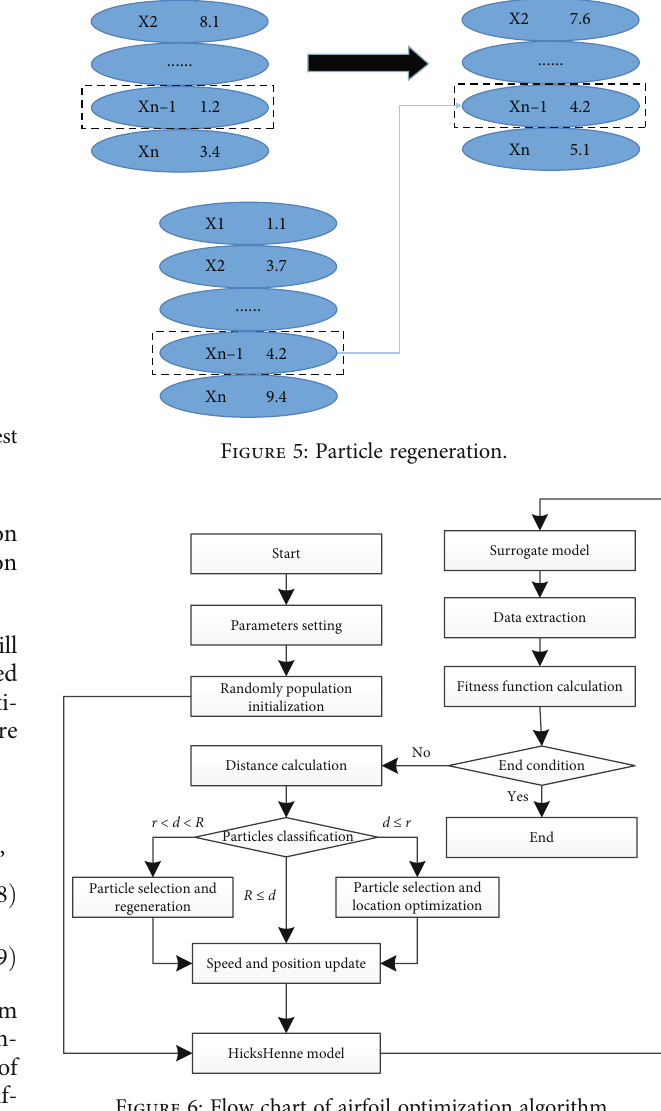
Figure 6: Flow chart of airfoil optimization